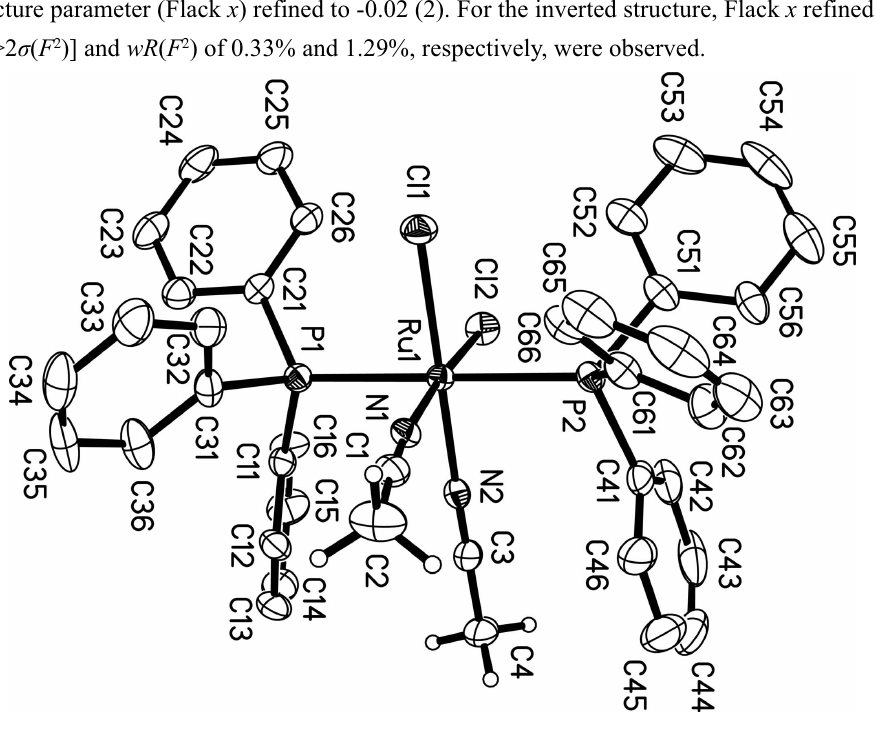
ORTEP view of the complex portion of the title compound, with displacement ellipsoids at the 50% probability level. Phenyl hydrogen atoms and acetonitriles of crystallization are omitted for